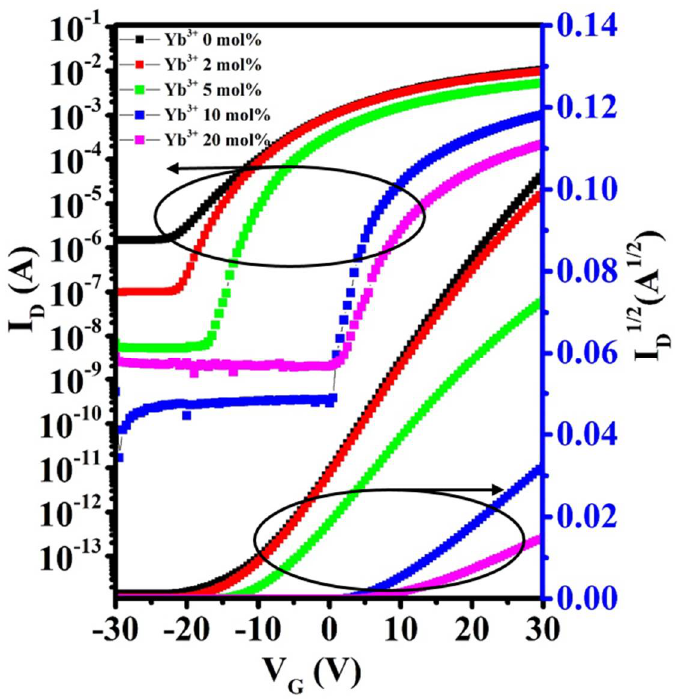
Figure 6. ( a ) Schematic architecture, ( b ) cross-sectional TEM image of the In-Yb-O (10% Yb) device, and ( c ) HRTEM image of selected area marked with a red circle in panel b.